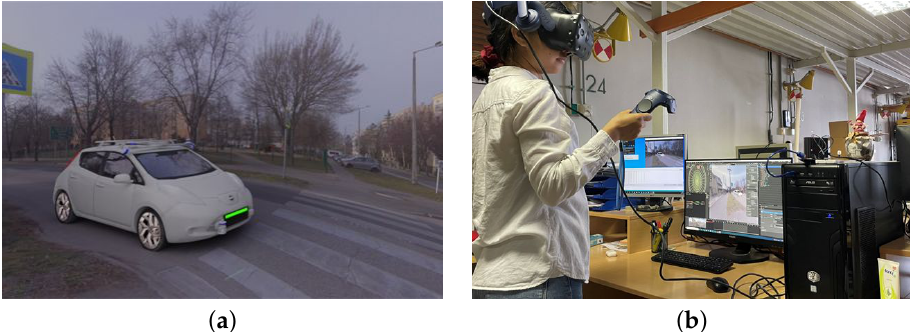
Figure 1. Simulation ( a ) Model of the AV in the 3D environment. ( b ) The experiment in